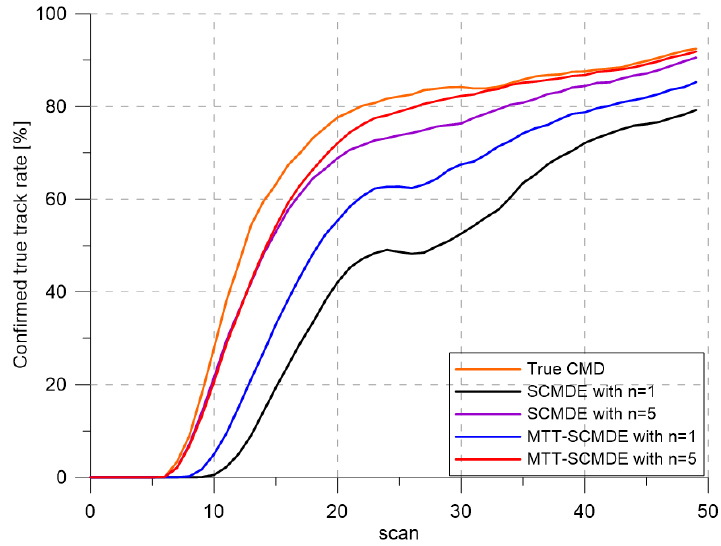
Figure 9. Confirmed true track